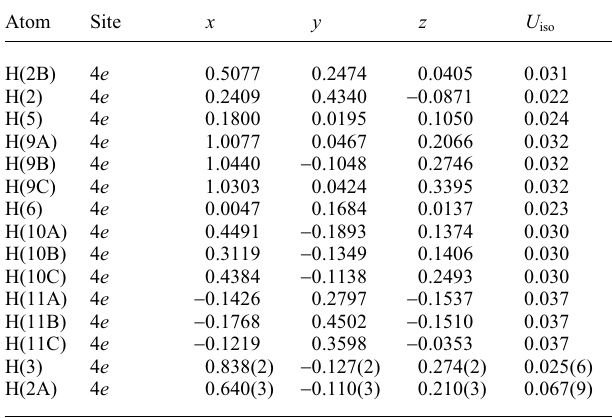
Table 2. Atomic coordinates and displacement parameters (in Å 2 )